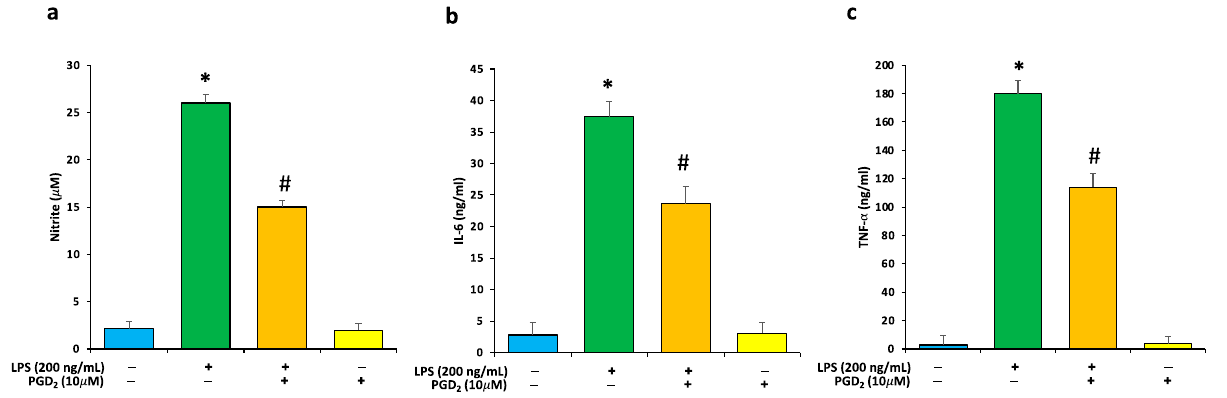
Figure 2. Role of PGD 2 as an anti-inflammatory agent on LPS-exposed RAW264.7 macrophages. The macrophages were pretreated with PGD 2 (10 µ M) for 1 h and exposed to LPS (200 ng/mL) for an extra 24 h. The figure ( a ) represents NO; ( b ) IL-6; and ( c ) TNF- α in different treatment groups. Statistically significant differences ( p < 0.05) are marked with (*) between the NC and LPS groups and with (#) between the NC and LPS + PGD 2 group.